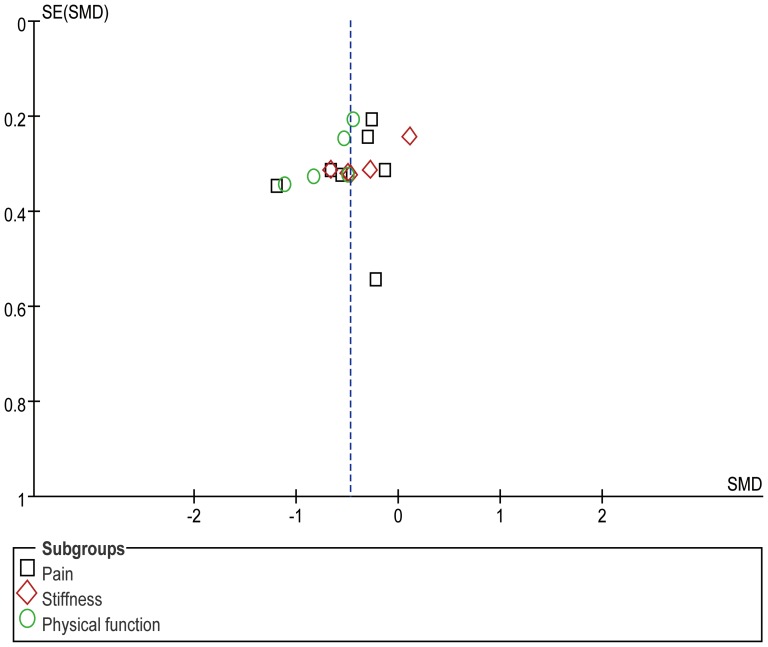
A Funnel plot for pain, stiffness, and physical function.